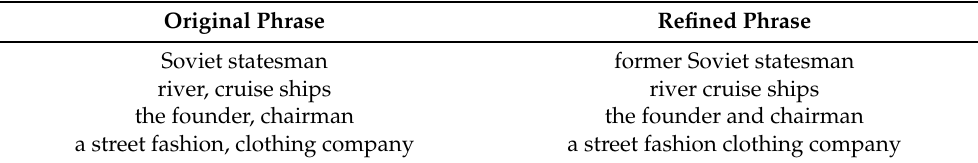
Table 1. Examples of refined phrases. “Original phrase” is extracted via the Stanford CoreNLP toolkit. “Refined phrase” denotes the results constrained by designed grammar